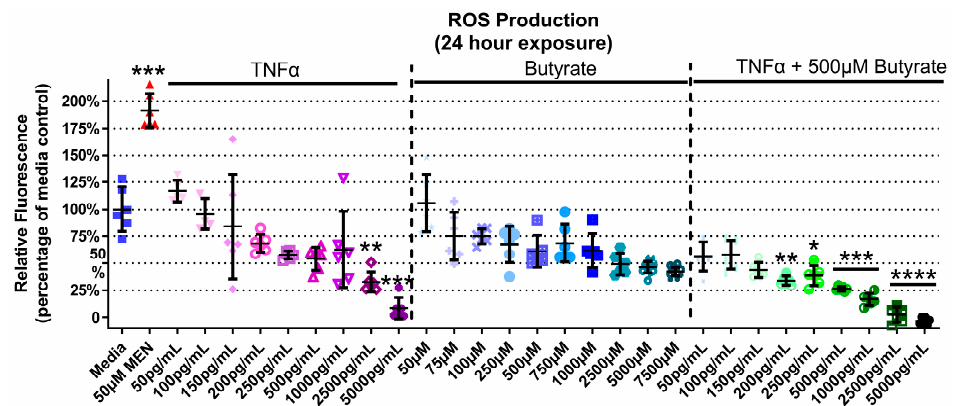
Figure 5. Reactive oxygen species (ROS) production of primary rat colon epithelial cells after exposure to butyrate and TNF α at 24 h. Menadione (MEN) was used as a positive control as a potent inducer of ROS (mean fluorescence ± standard deviation) (n = 3). Asterisks indicate degree of significance from medium control (Kruskal–Wallis test followed by a Dunn’s multiple comparison test relative to the medium control, n = 3; significance determined at * = p < 0.05, ** = p < 0.01, *** = p < 0.001, **** = p < 0.0001). Note: for statistical comparisons made amongst all groups, see Supplemental